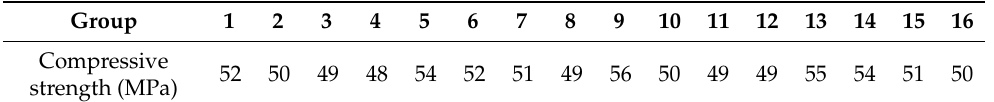
Table 8. Compressive strength at 28